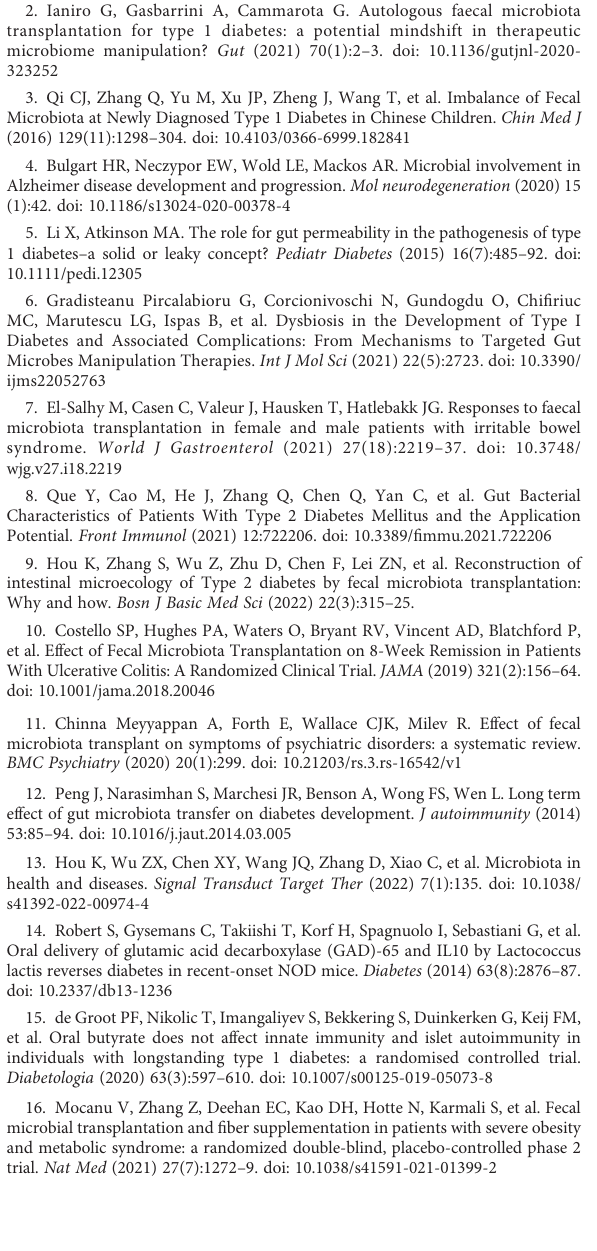
SUPPLEMENTARY FIGURE 1 PCA samples from patient1 (A) and patient 2 (B) shown by changes in the micro fl ora at each time visiting